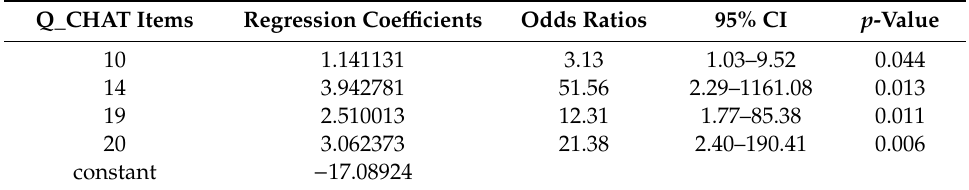
Table 4. Results of the multivariate logistic regression analysis stepdown procedure on the association between diagnosis of ASD or BAP at 36 months and Q-CHAT items significantly associated at the bivariate logistic regression at 18 months of age (Items 1, 2, 4, 5, 6, 7, 8, 9, 10, 14, 15, 16, 17, 19, 20, 23 and 25).